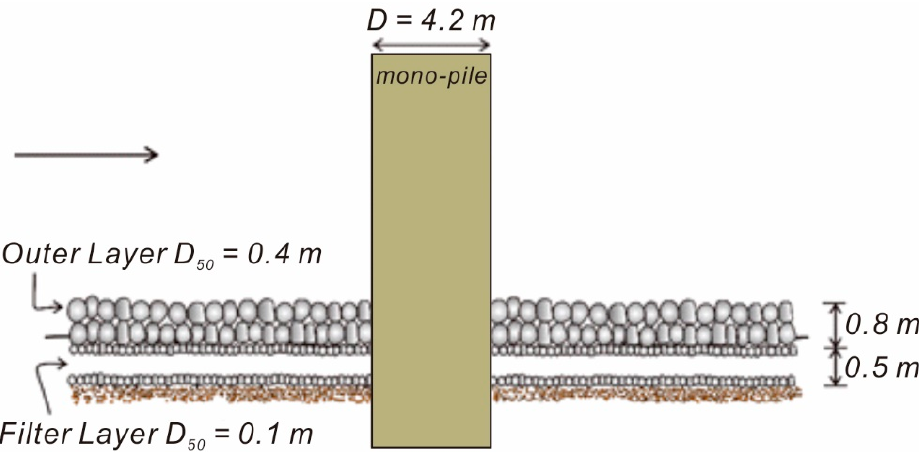
Figure 4. Schematic sketch of the scouring protection system of laying finer grade stones as a filter layer under the top scour protection cover (reproduced from [9]).